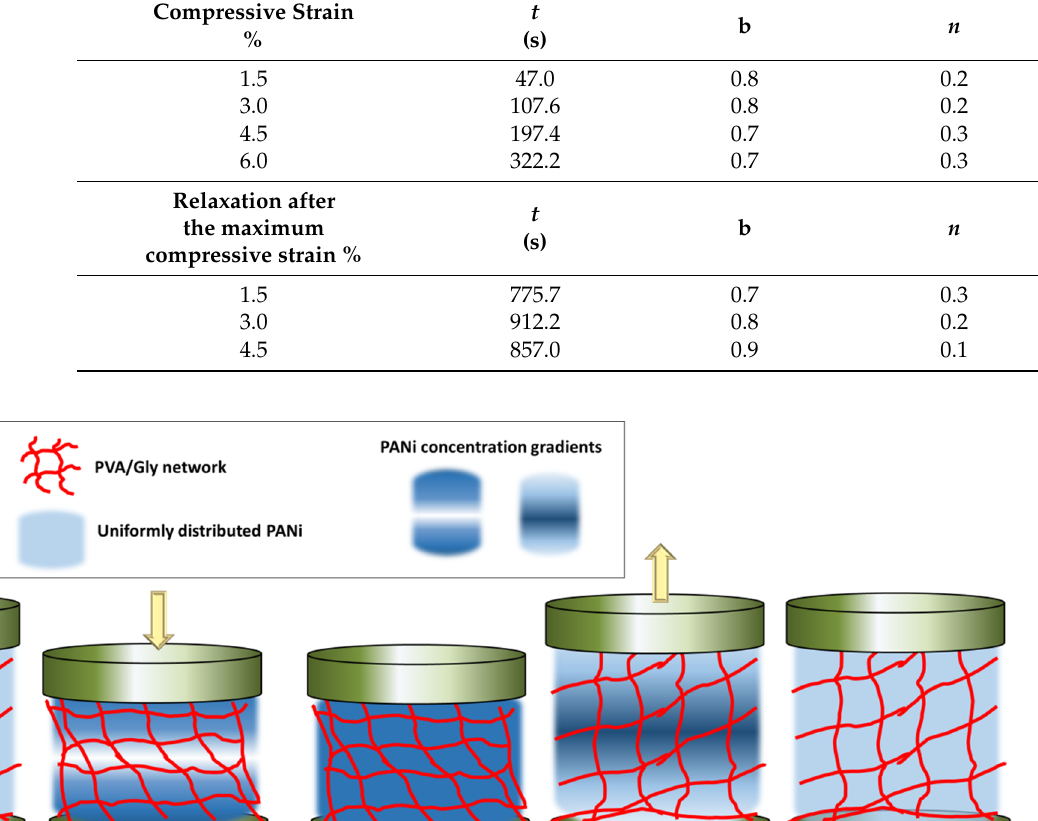
Table 2. The values for τ , β and n obtained by fitting the Equation (1) to the portion of the relaxation at constant strain.